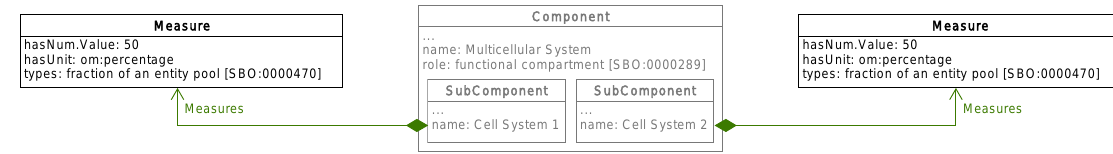
Figure 24: Annotating class instances with cellular proportions. Instances of the Measure class are used to capture the percentage of each cell type present in the multicellular system